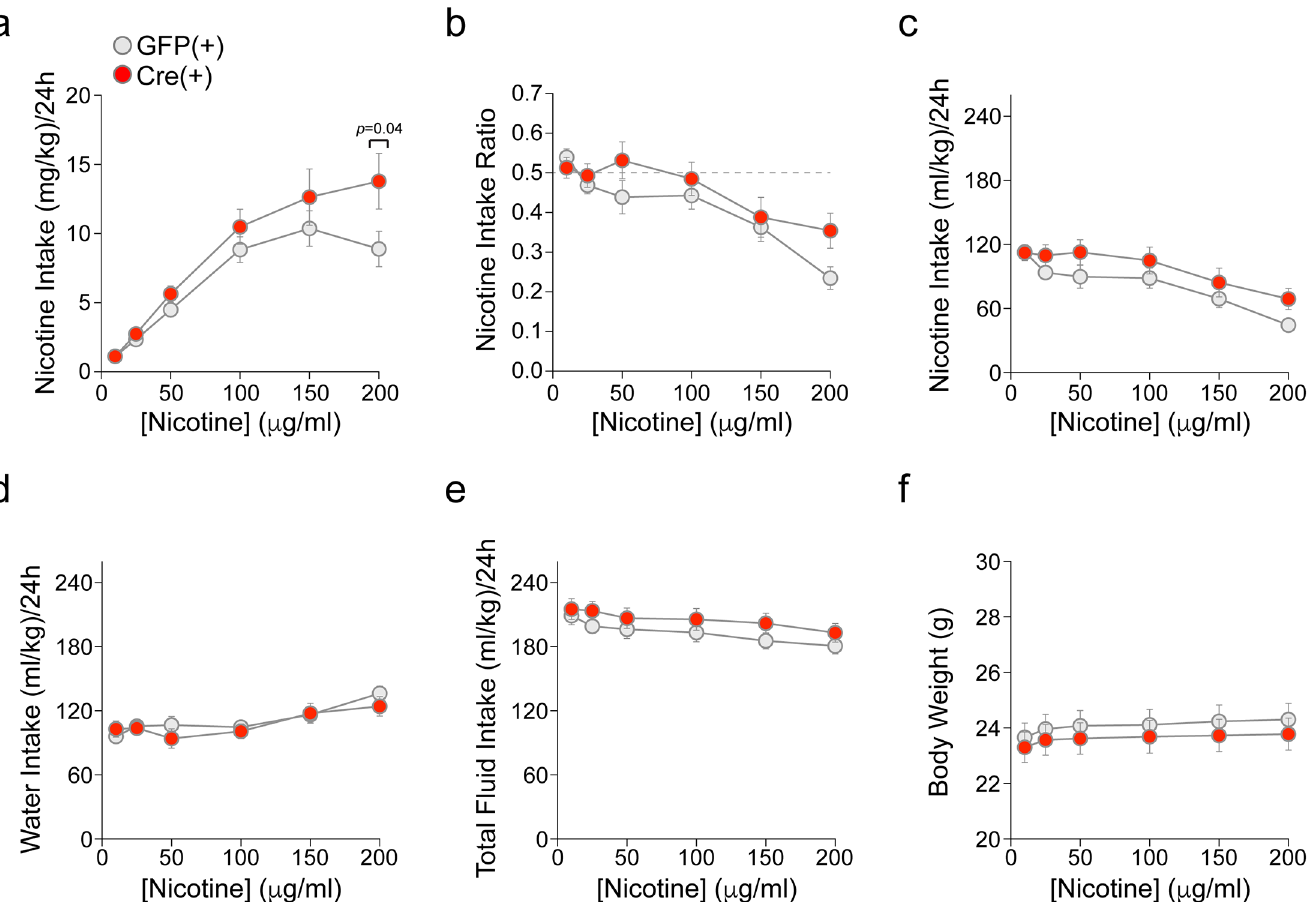
Fig 2. Enhanced nicotine oral SA in mice with vMB α 4 deletion. a) Mean ( ± SEM) nicotine intake (mg/kg) over 4 days is shown for each nicotine concentration, in male and female α 4-flox GFP(+) (n = 26) and Cre(+) (n = 24) mice. * p < 0.05.b) Mean ( ± SEM) nicotine intake ratio (fraction of nicotine- containing fluid consumedrelativeto total fluid consumed) over 4 days is shown for each nicotineconcentration in α 4-flox GFP(+) and Cre(+) mice. c) Mean ( ± SEM) intake of nicotinesolution (mL/kg), used to calculatemass of nicotine intake shown in (a), is shown for each nicotineconcentration in α 4-flox GFP(+) and Cre(+) mice. d) Mean ( ± SEM) water intake (mL/kg) over 4 days is shown for each nicotine concentration in α 4-floxGFP(+) and Cre(+) mice. e) Mean ( ± SEM) total fluid intake (mL/kg) over 4 days is shown for each nicotineconcentration in GFP(+) and Cre(+) mice. f) Mean ( ± SEM) body weight (g) for α 4-flox GFP(+) and Cre(+) mice is shownfor each nicotine concentration. S2, S3 and S4 Figs show intake data separated by sex.